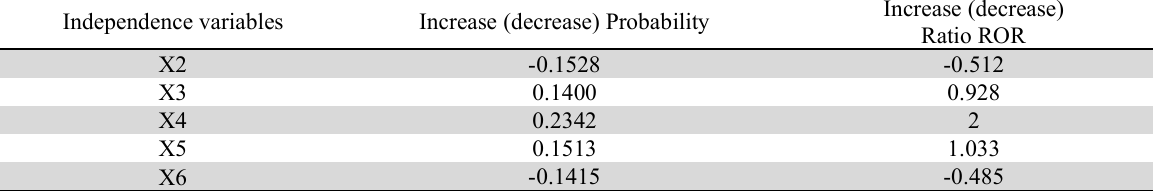
Effect of independent variables on the probability of using consulting services